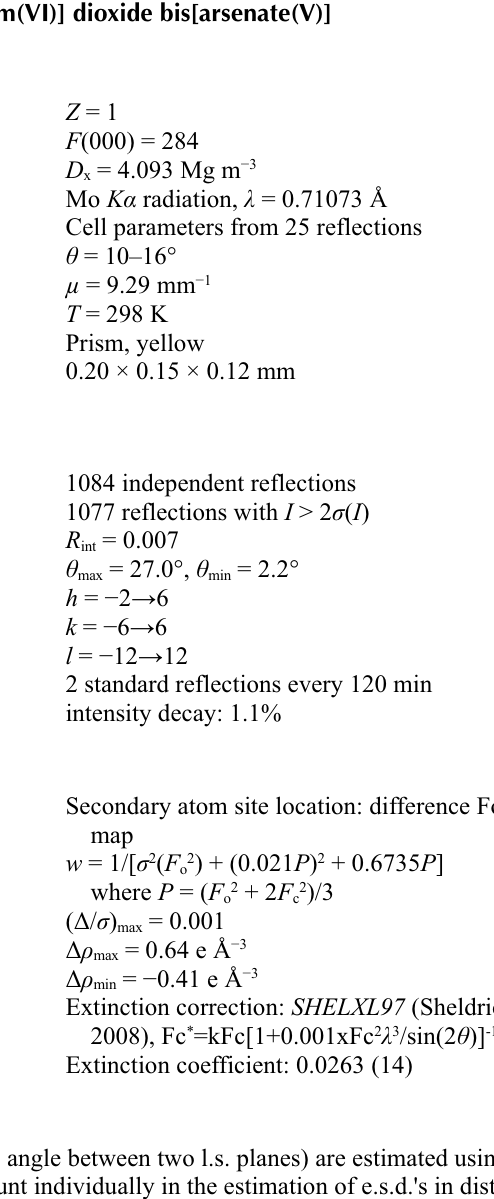
AlMo As O selon b montrant les larges canaux où résident les cations Li + . 3 2 2 14